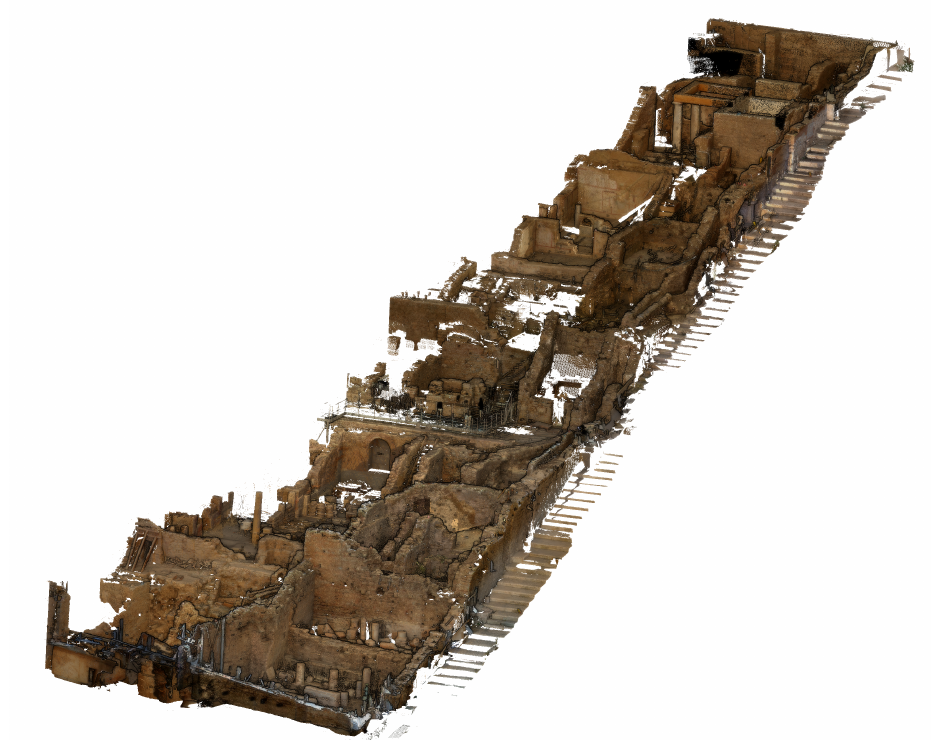
Figure 4. Original point cloud of Ephesos terrace house